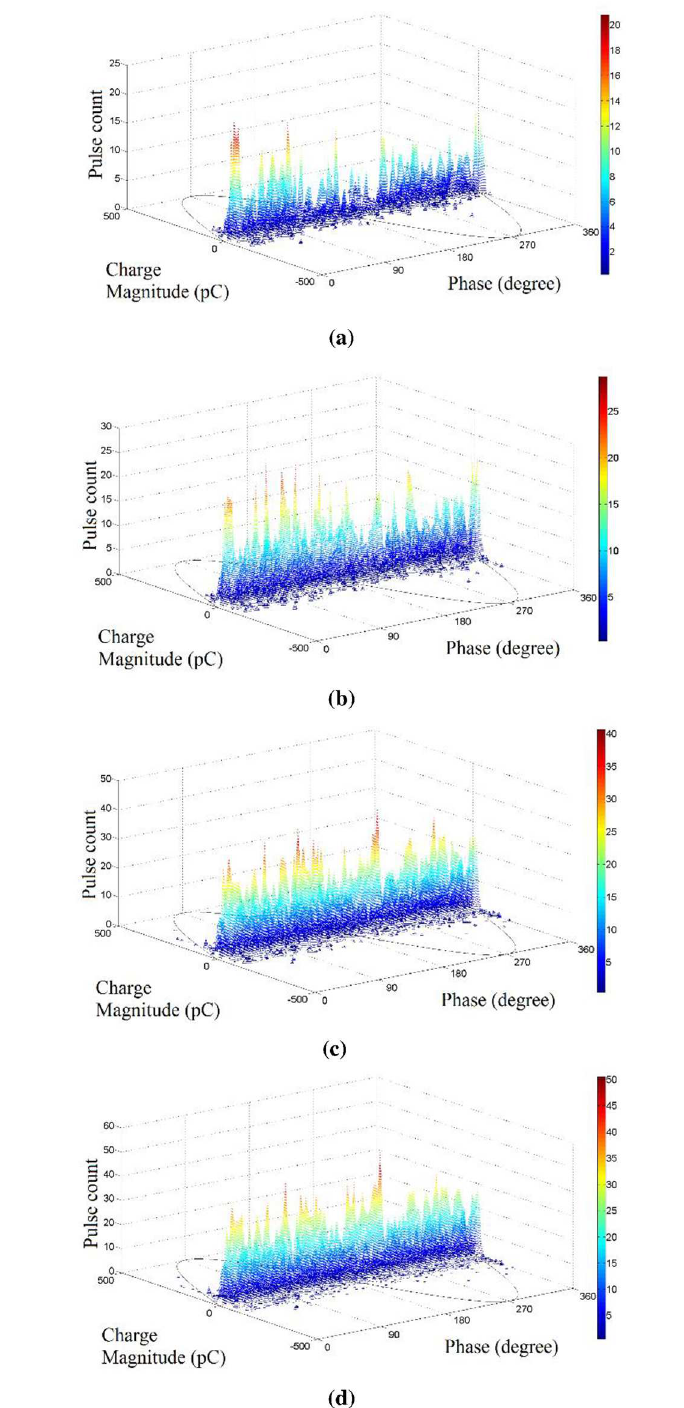
Fig 2. PRPD patterns of different noise duration; (a) 15 seconds, (b) 30 seconds, (c), 45 seconds, and (d) 60 seconds.